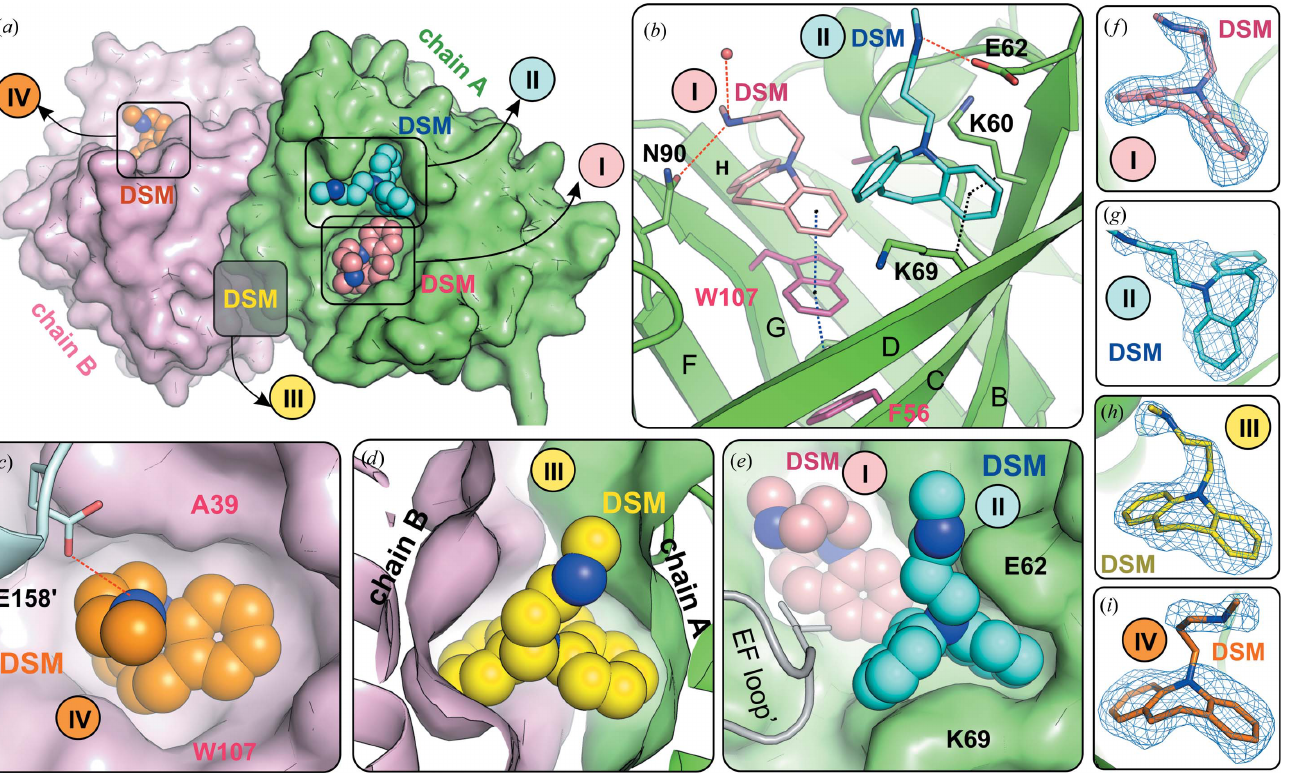
Figure 3 ( a ) Crystal structure of the FAW–DSM#1 complex. The molecular surface of the protein shows excellent shape complementarity between the ligands and the protein binding sites. DSM molecules I, II, III and IV (numbering as for FAF–DSM in Fig. 2) are shown in space-filling representation. ( b ) The interactions stabilizing DSM molecules I and II in the (cid:2) -barrel sites of subunit A : hydrogen bonds (red dashed lines), hydrophobic contacts or C—H (cid:7)(cid:7)(cid:7) (cid:3) interactions (black dotted lines) and (cid:3) – (cid:3) stacking interactions (blue dotted lines). ( c ) DSM IV in subunit B is additionally stabilized by a hydrogen bond to Glu158 0 from a symmetry-related molecule (marked by a prime). ( d ) Shape complementarity between DSM III and the binding site at the dimer interface (green, subunit A ; pink, subunit B ). ( e ) Shape of the binding sites in the (cid:2) -barrel interior (DSM I) and (cid:2) -barrel entrance (DSM II) of subunit A . DSM II at the (cid:2) -barrel entrance is additionally stabilized by the EF loop from a symmetry-related FAW molecule. ( f )–( i ) 2 F o (cid:3) F c electron-density map contoured at 1.0 (cid:6) around DSM ligand molecules I, II, III and IV (difference omit maps are presented in Supplementary Fig.